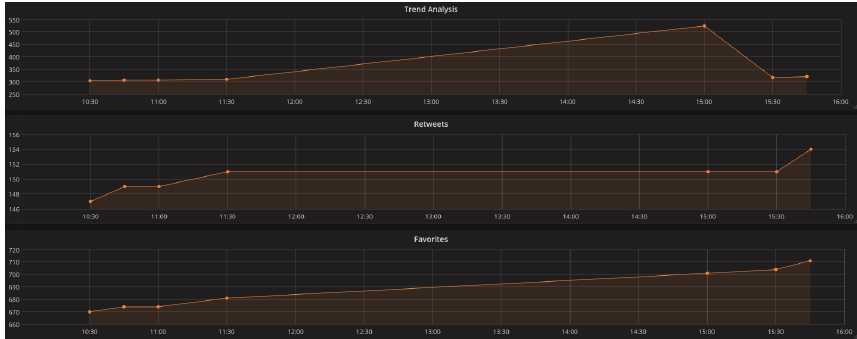
Figure 4. Trend power compared to retweets and favorites over